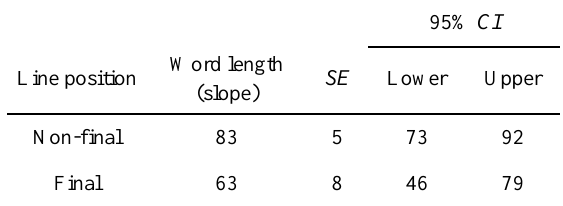
Table A9. Total reading time per word: Interaction of word length and line